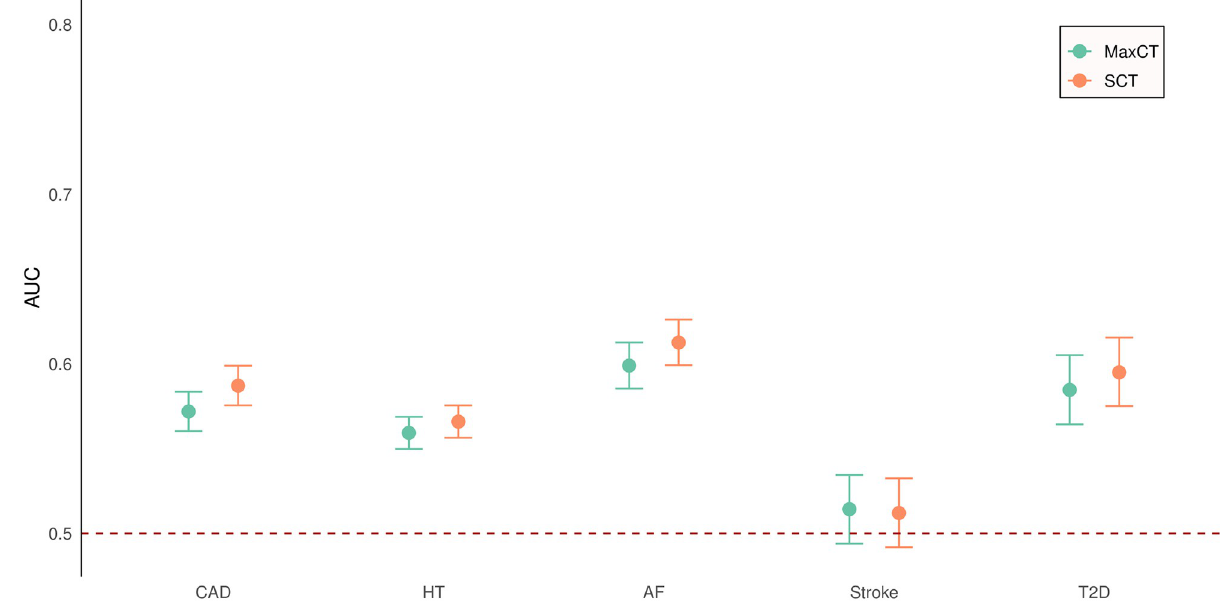
Fig 2. Predictive performance of the PRSs generated by maxCT and SCT for five common diseases as measured by AUC.